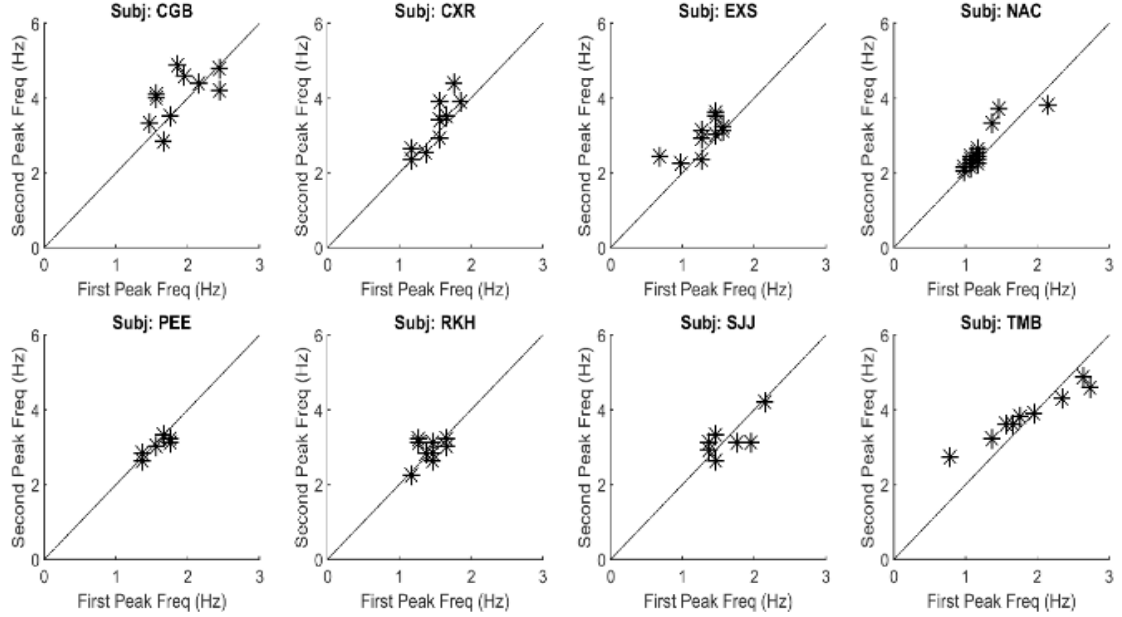
Figure 7: A plot of the frequency of the second spectral peak versus that of the first spectral peak for all responses and all subjects. The points fall close to a straight line with a slope of 2.0 showing that the frequency of the second spectral peak is approximately double that of the first. All correlations between the two parameters were significant at p < 0.01. This suggests that oscillations above those of the fundamental frequency are harmonics probably produced by nonlinearities in the slow component feedback system.